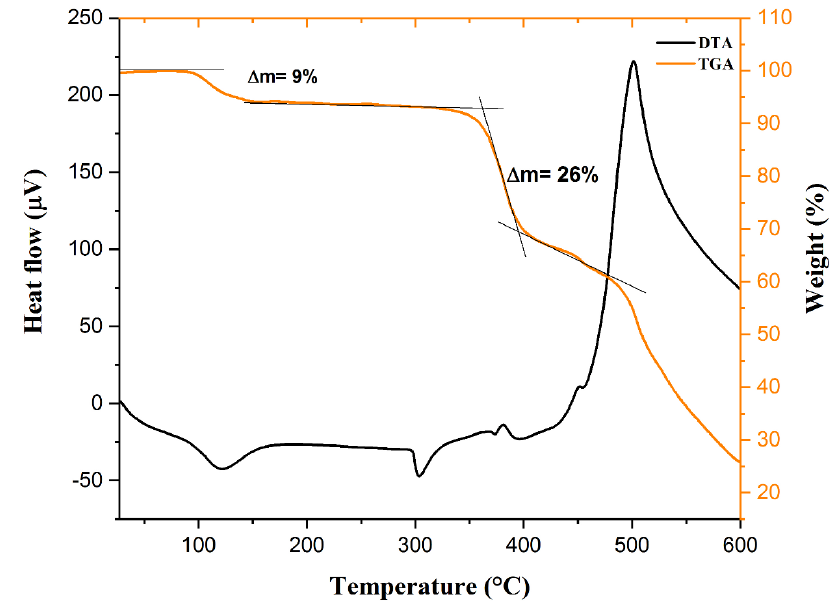
Figure 7. TGA and DTA of the [Ni 2 HL 2 (EtOH) 2 ](Cl)(EtOH) complex.